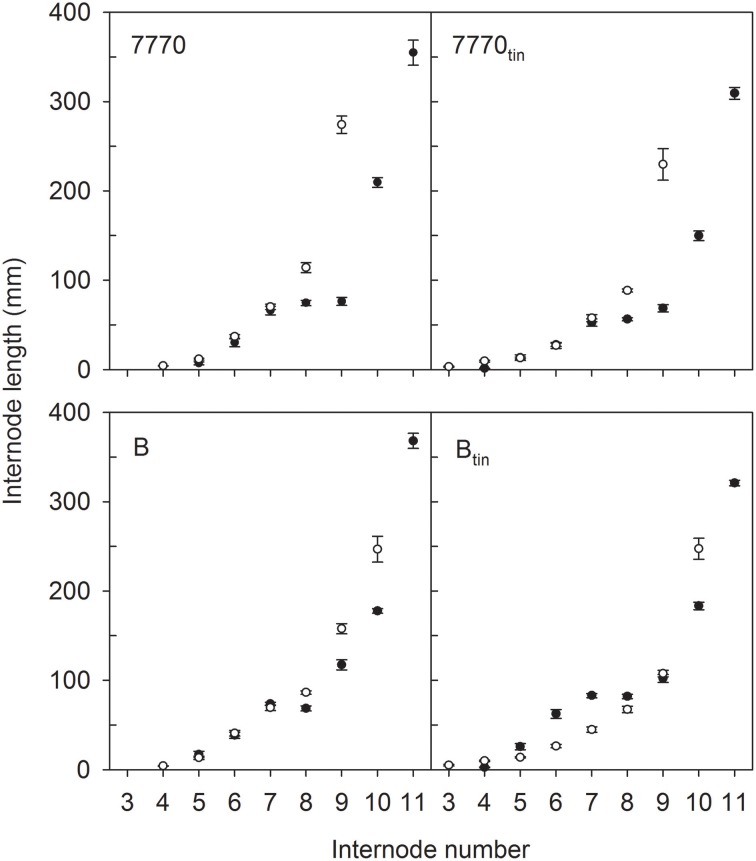
Internode lengths of two pairs of near-isogenic lines differing in the tin gene (7770/7770tin and B/Btin) grown at Canberra in 2012 (white symbols) and 2013 (black symbols). The values at the highest internode number represent the peduncle length, and numbers of subjacent internodes correspond to the respective phytomer numbers. Error bars show ± one standard error.